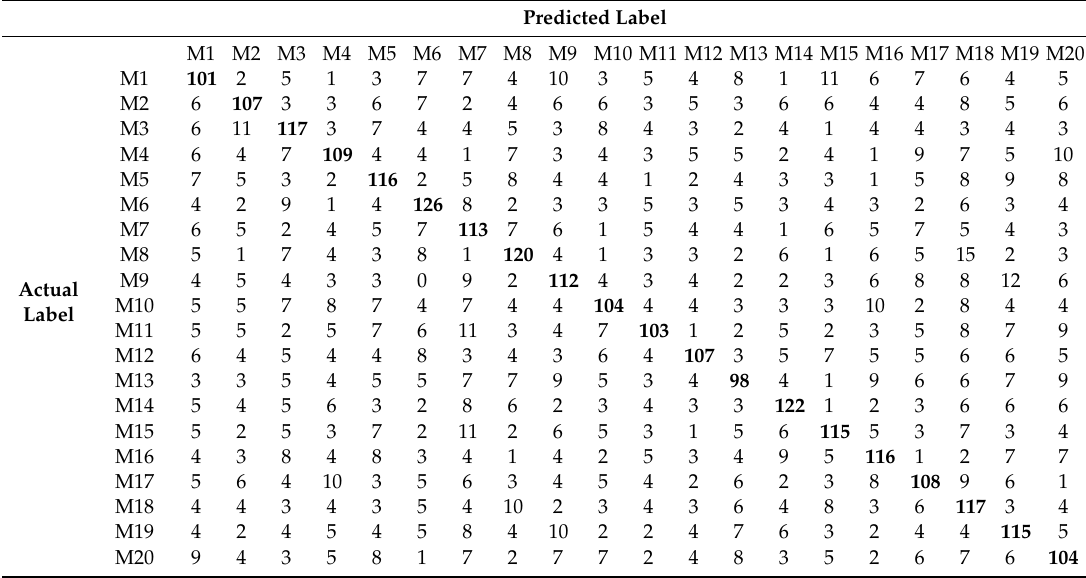
Table 4. The total classification results of 20